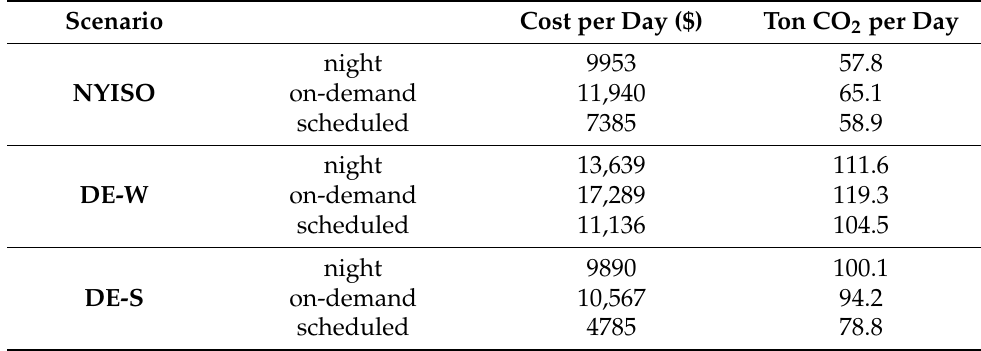
Table 3. Results over 4